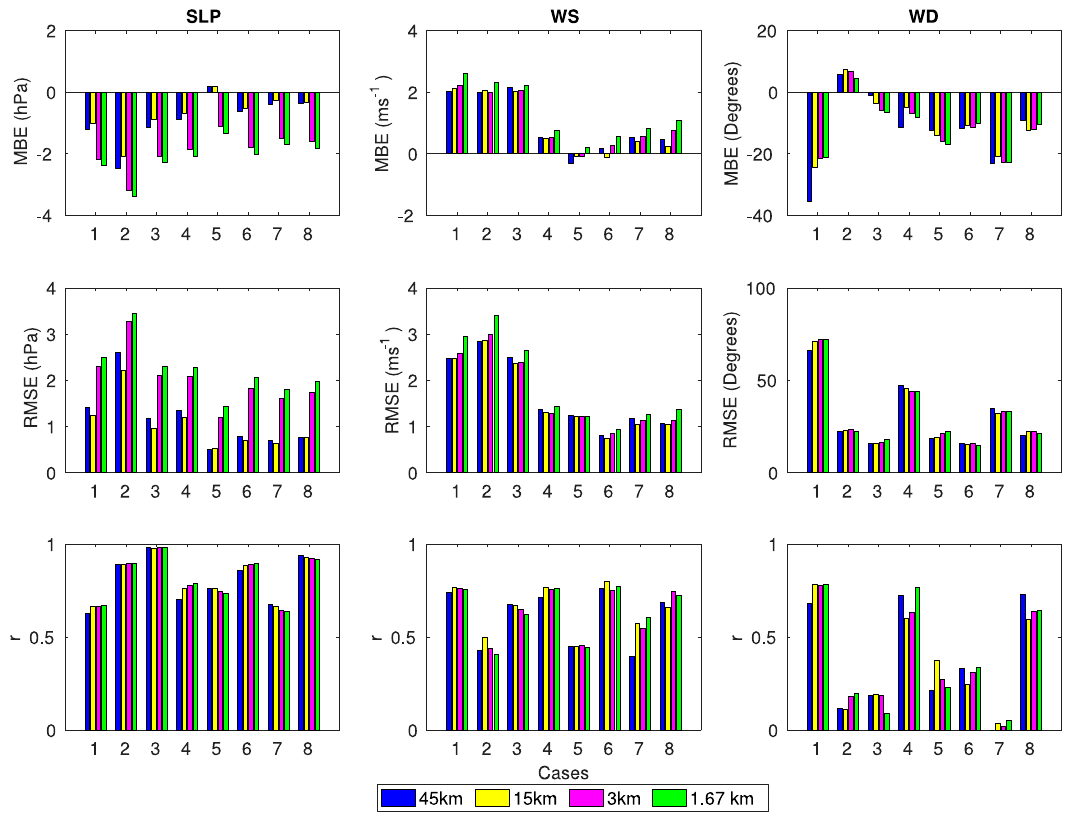
Figure 6. Evaluation statistics MBE (top), RMSE (middle), and r (bottom) for circulation variables sea-level pressure (SLP, left), wind speed (WS, centre), and wind direction (WD, right) for intermittent (1–4) and clear cases (5–8) simulated with WRF-Solar.